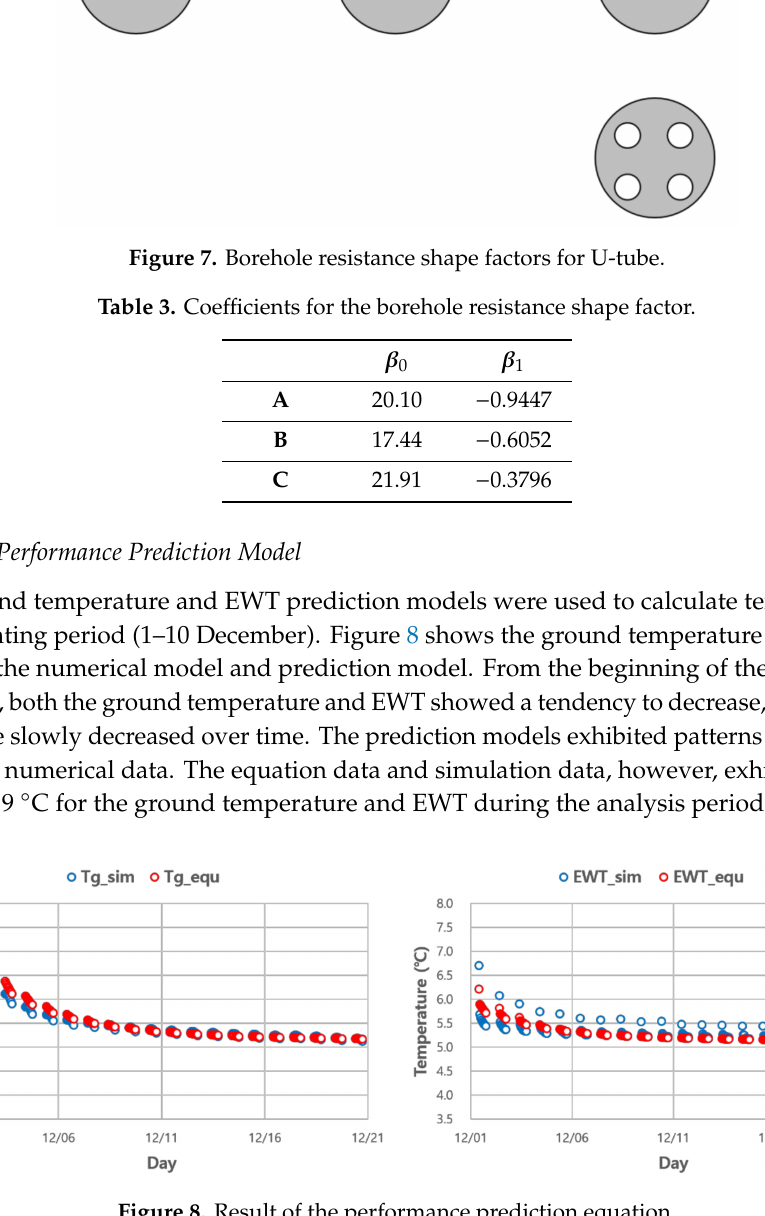
Figure 8. Result of the performance prediction equation. Table 4. Comparison of simulation and equation